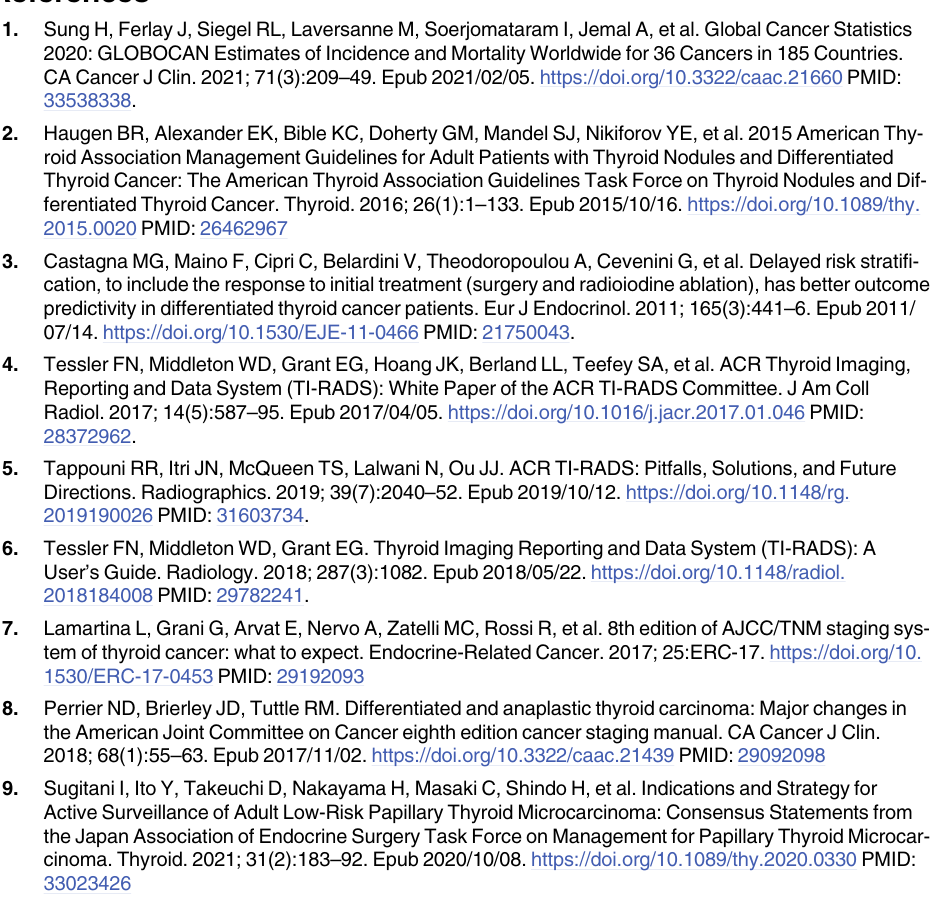
S1 Table. Clinical parameters of DTC cases included in this